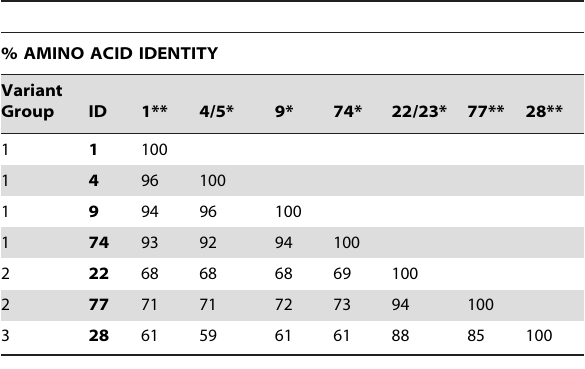
Amino acid identity from pair-wise alignments between fHbp sequence variants.